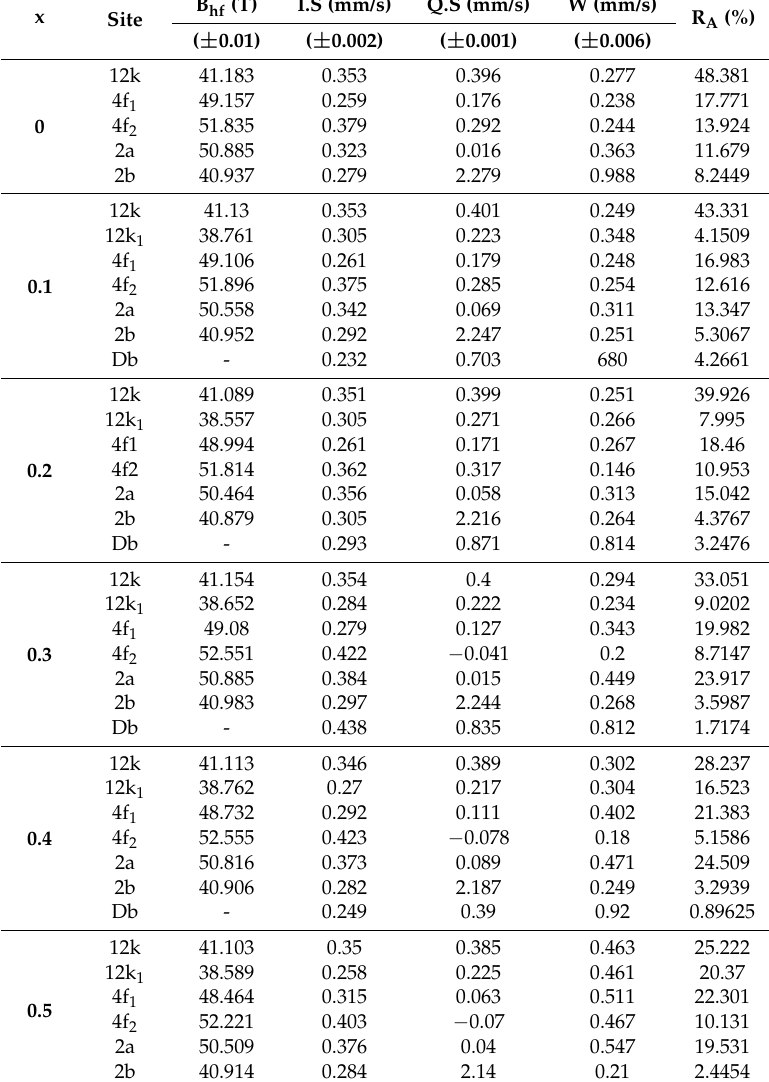
Table 2. Mössbauer spectral parameters of the studied Sr 1 − x Mn x Fe 12 − x Y x O 19 (0.0 ≤ x ≤ 0.5) nanohexaferrites including hyperfine magnetic field (B hf ), isomer shift (I.S), quadrupole splitting (Q.S), line width (W), and relative area percent (R A %) with estimated